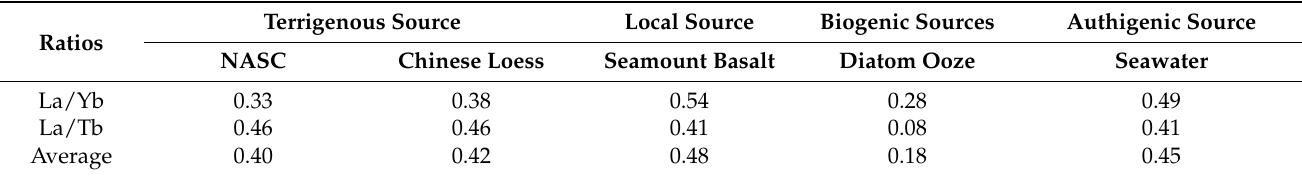
Table 2. The DF values of sediments of our